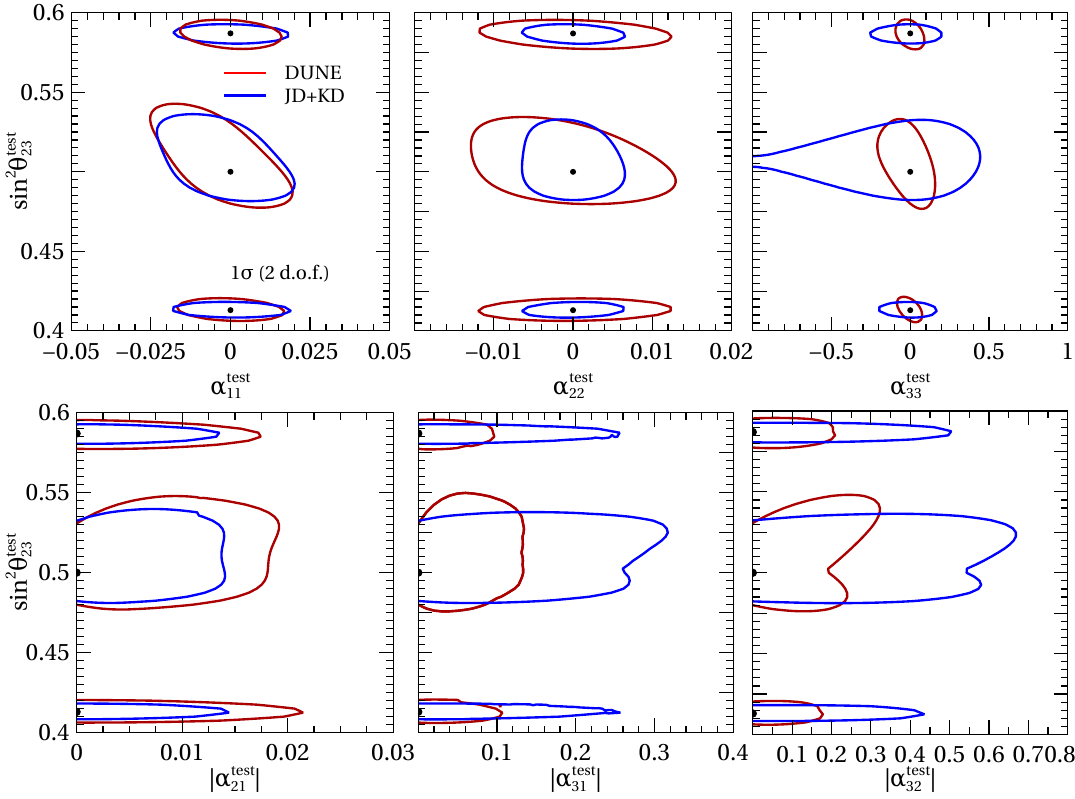
Figure 4 . 1 σ (2 d.o.f.) C.L. contours in the ( θ 23 - α ij ) planes for DUNE (red curves) and JD+KD (blue curves). The true values of θ considered here are θ = 40 ◦ , 45 ◦ , and 50 ◦ (shown by the 23 23 black dots in each panel). True value of δ is considered to be − 90 ◦ . In the fit, δ and the phases CP CP associated with off-diagonal NUNM parameters (see lower panels) are marginalized over the range of [- 180 ◦ , 180 ◦ ]. The other oscillation parameters are fixed at their best fit values (see table 2).